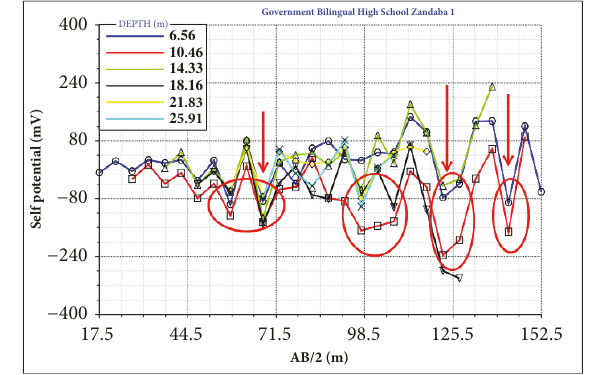
Figure14:PlotsofSPvaluesagainstHalfElectrodesSpacing(AB/2).